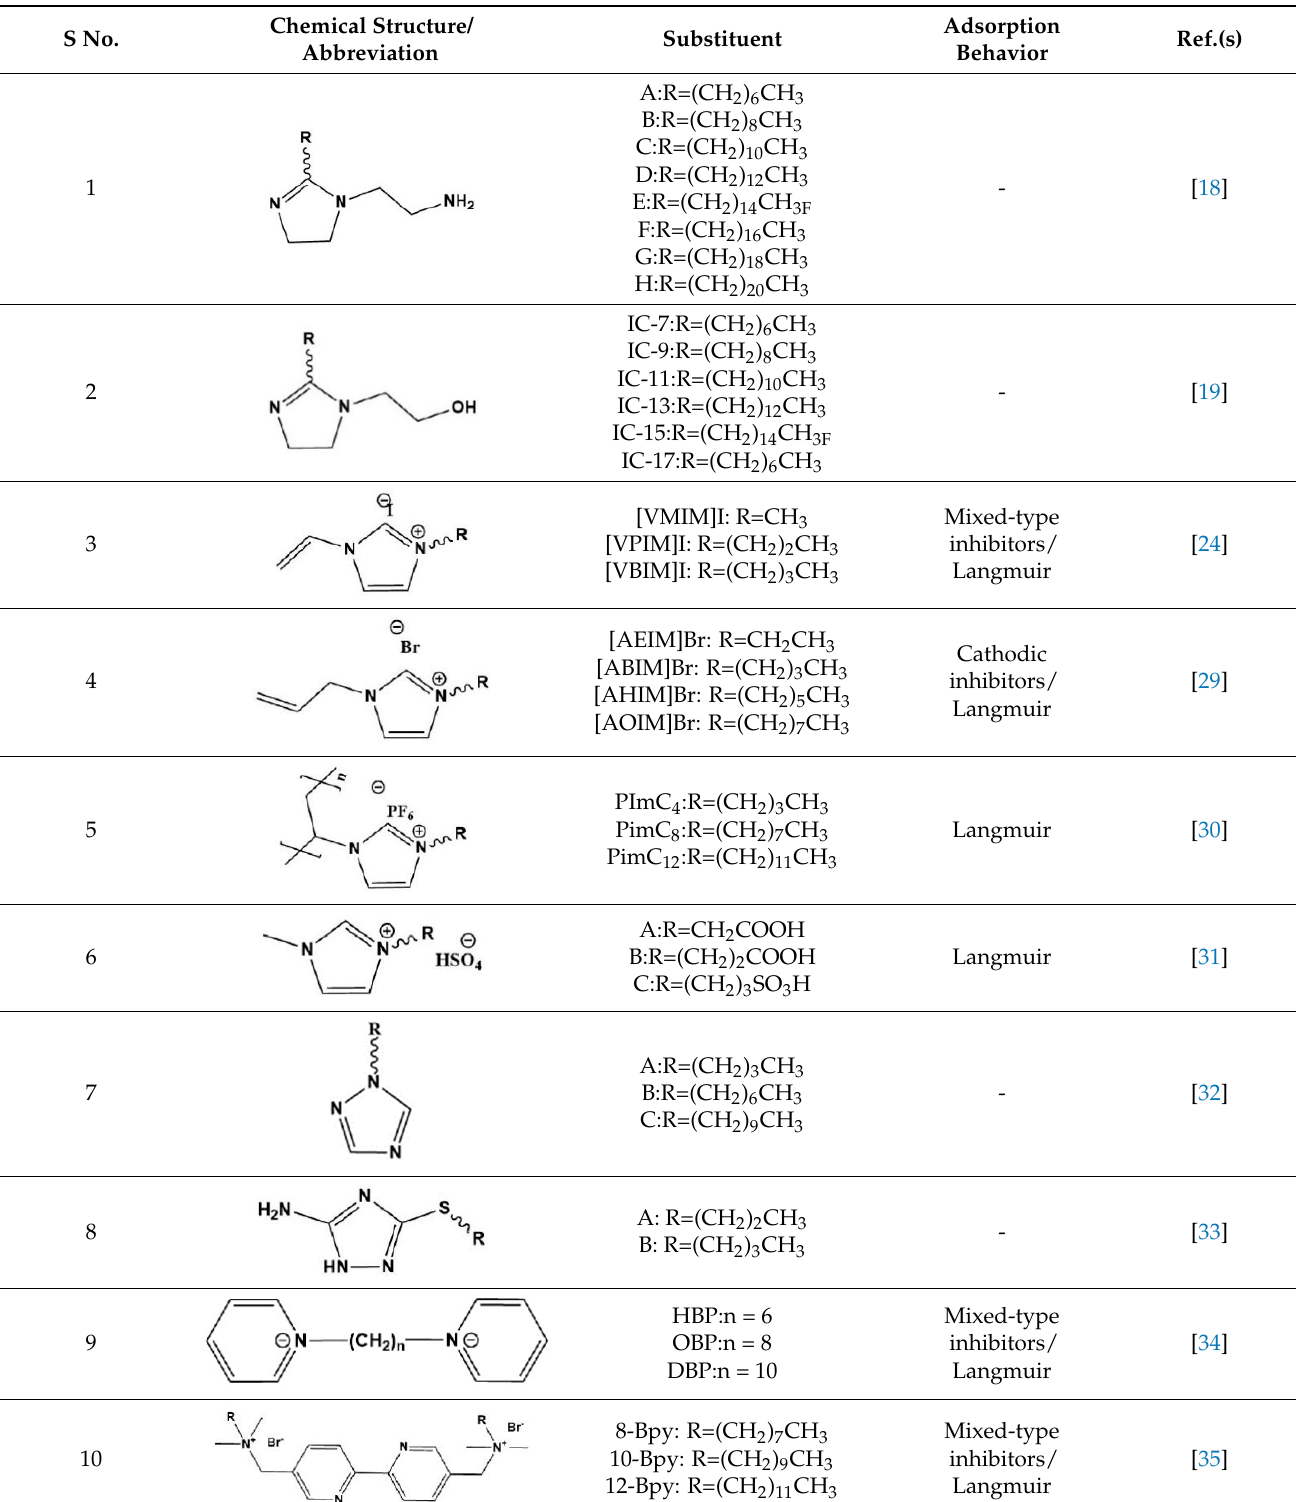
Table 1. Structural formulas of N-heterocycles with different alkyl chain lengths.